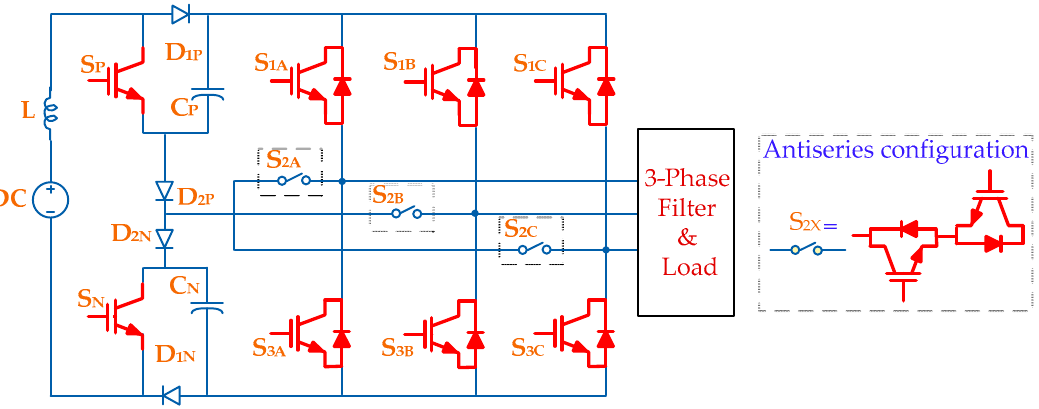
Figure 31. 3L qSBI T-Type inverter topology with anti-series configuration switches.